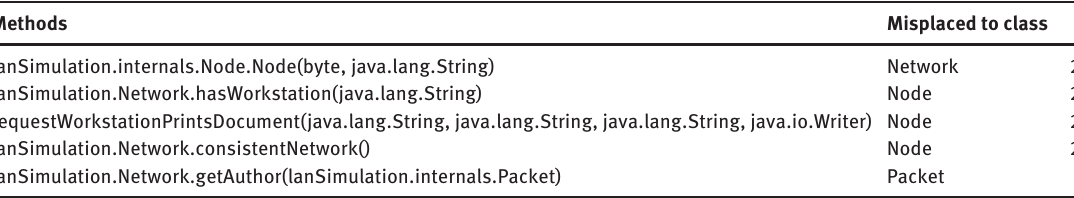
Table 4. Manually Misplaced Methods for LAN-Simulation.